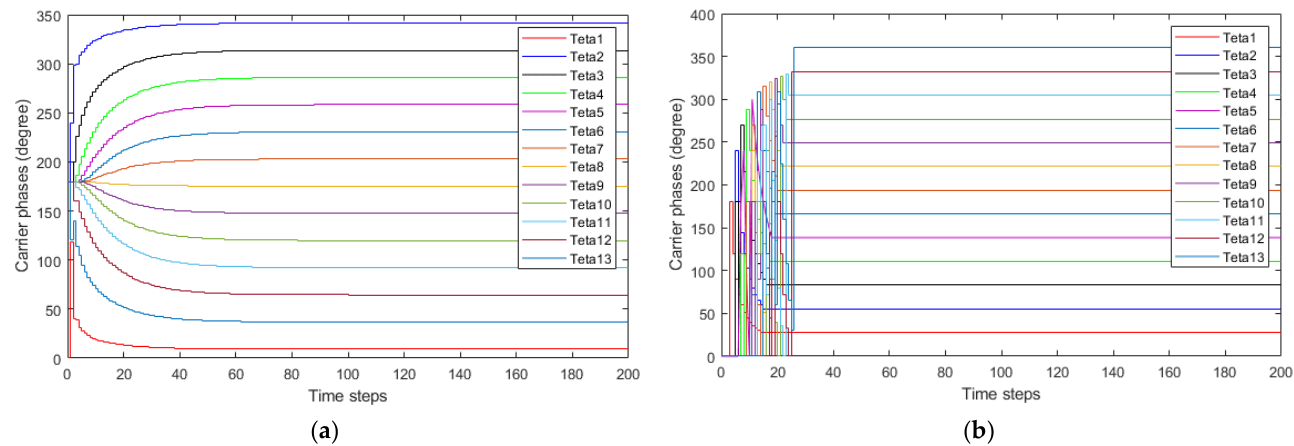
Figure 26. Configuration process of a converter with 13-carriers, startup with ( a ) conventional modified updating rule; ( b ) proposed DSA-PSC.